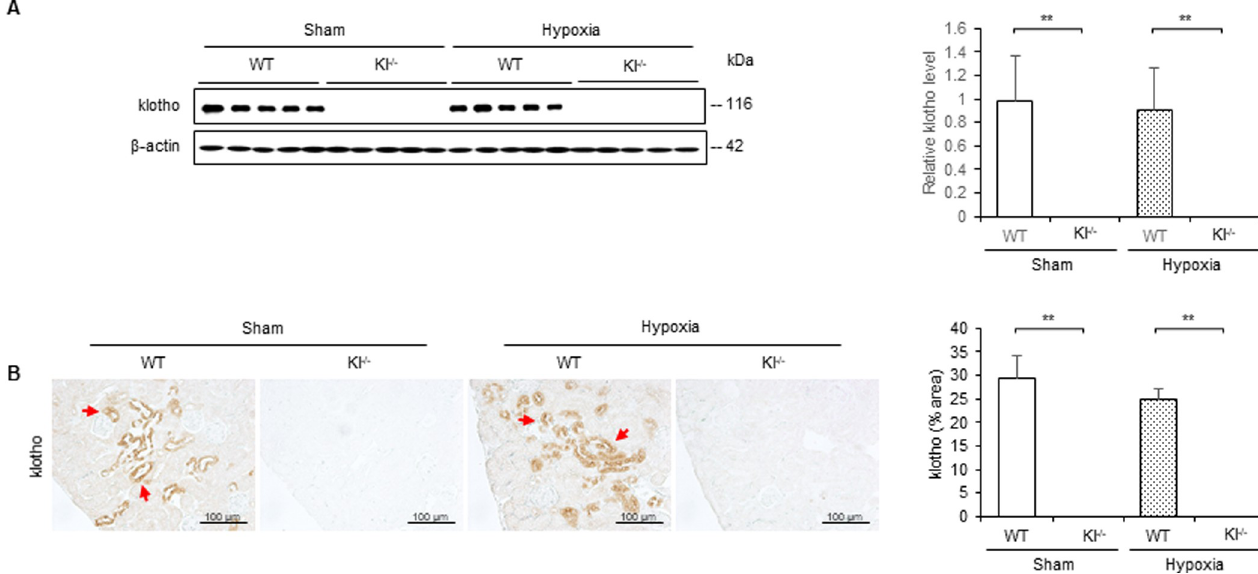
Fig 4. Expression level of klotho does not change during 10 min of hypoxic stimulation in WT and Kl − / − mice. Renal hypoxia was induced by clamping the renal artery for 10 min in WT mice and Kl − / − mice. (A) Western blot analysis demonstrating klotho expression in WT and Kl − / − mice. Protein levels were normalized to β -actin levels (n = 5 in each group). (B) Representative immunohistochemical staining images showing expression and localization of klotho in WT and Kl − / − mice. Values are mean ± SD. � P < 0.05, �� P < 0.01. Bar = 100 μ m.